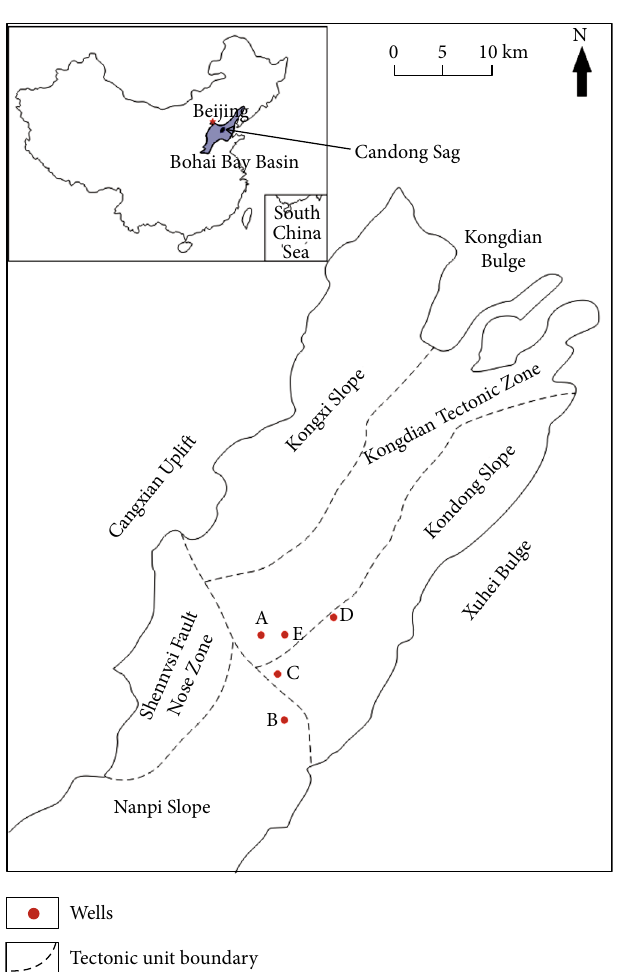
Figure 1: Map of Cangdong Sag in Bohai Bay Basin and location of fi ve sampling wells (modi fi ed from